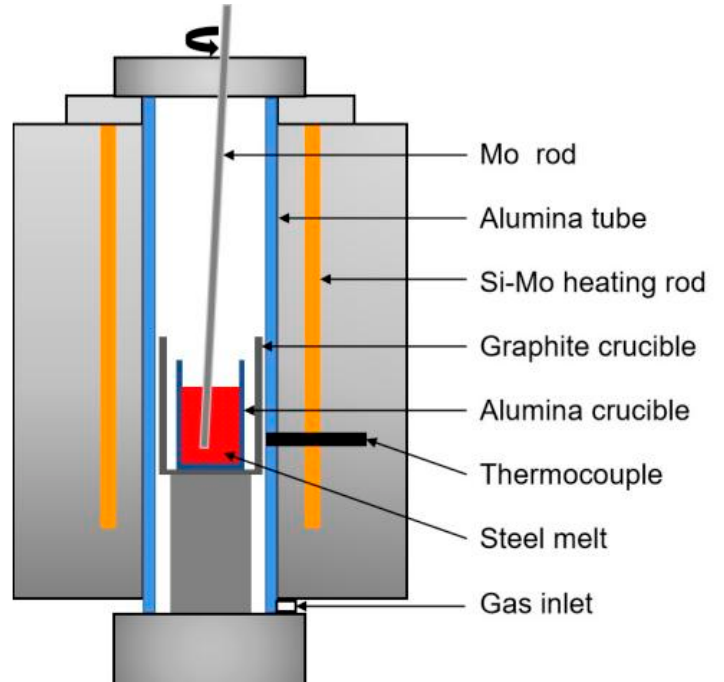
Figure 1. Structural diagram of the experimental tubular furnace.